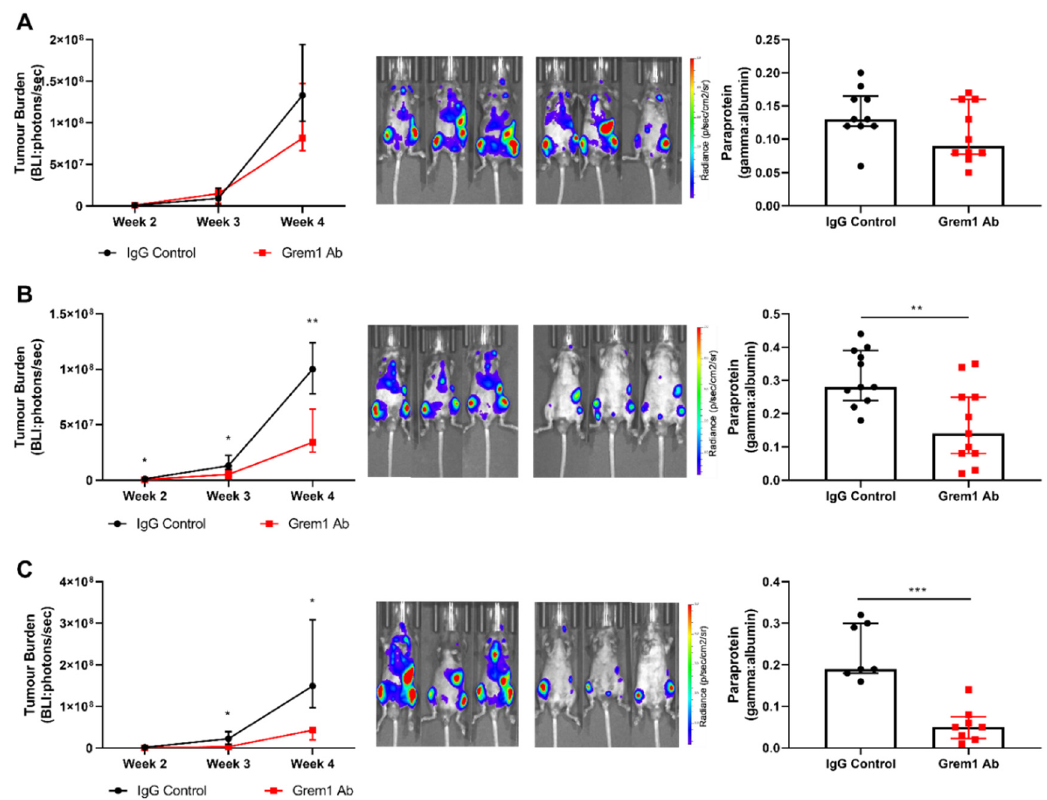
Figure 5. Anti-Grem1 antibody treatment reduces 5TGM1 tumor growth in vivo. KaLwRij mice were inoculated with 5 × 10 5 5TGM1.Bmx1 MM PCs. Mice were treated with either 30 mg/kg anti-Grem1 antibody or IgG isotype control antibody in three treatment regimens: ( A ) Late-stage established disease (once weekly treatment administered at weeks 2 and 3 posttumor cell inoculation, n =10/treatment group), ( B ) early-stage established disease (twice weekly treatment administered from day 3 posttumor cell inoculation, n =11/treatment group), and ( C ) prior to tumor engraftment (twice